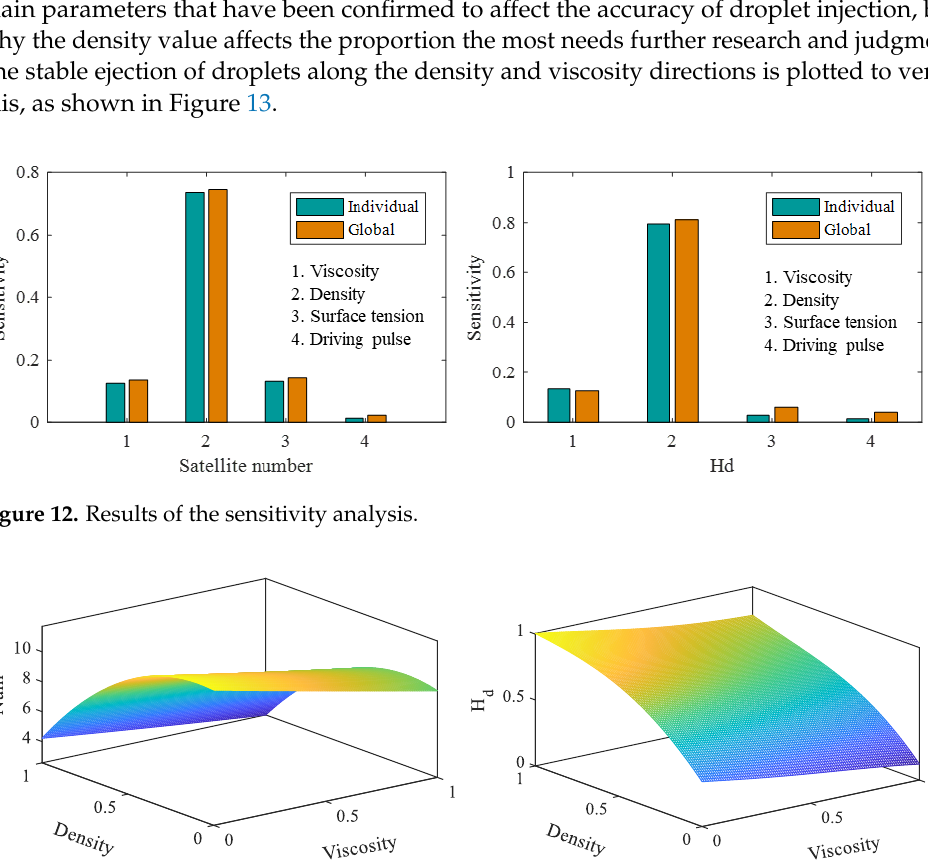
Figure 13. Surface plot of droplet ejection for density and viscosity settings.